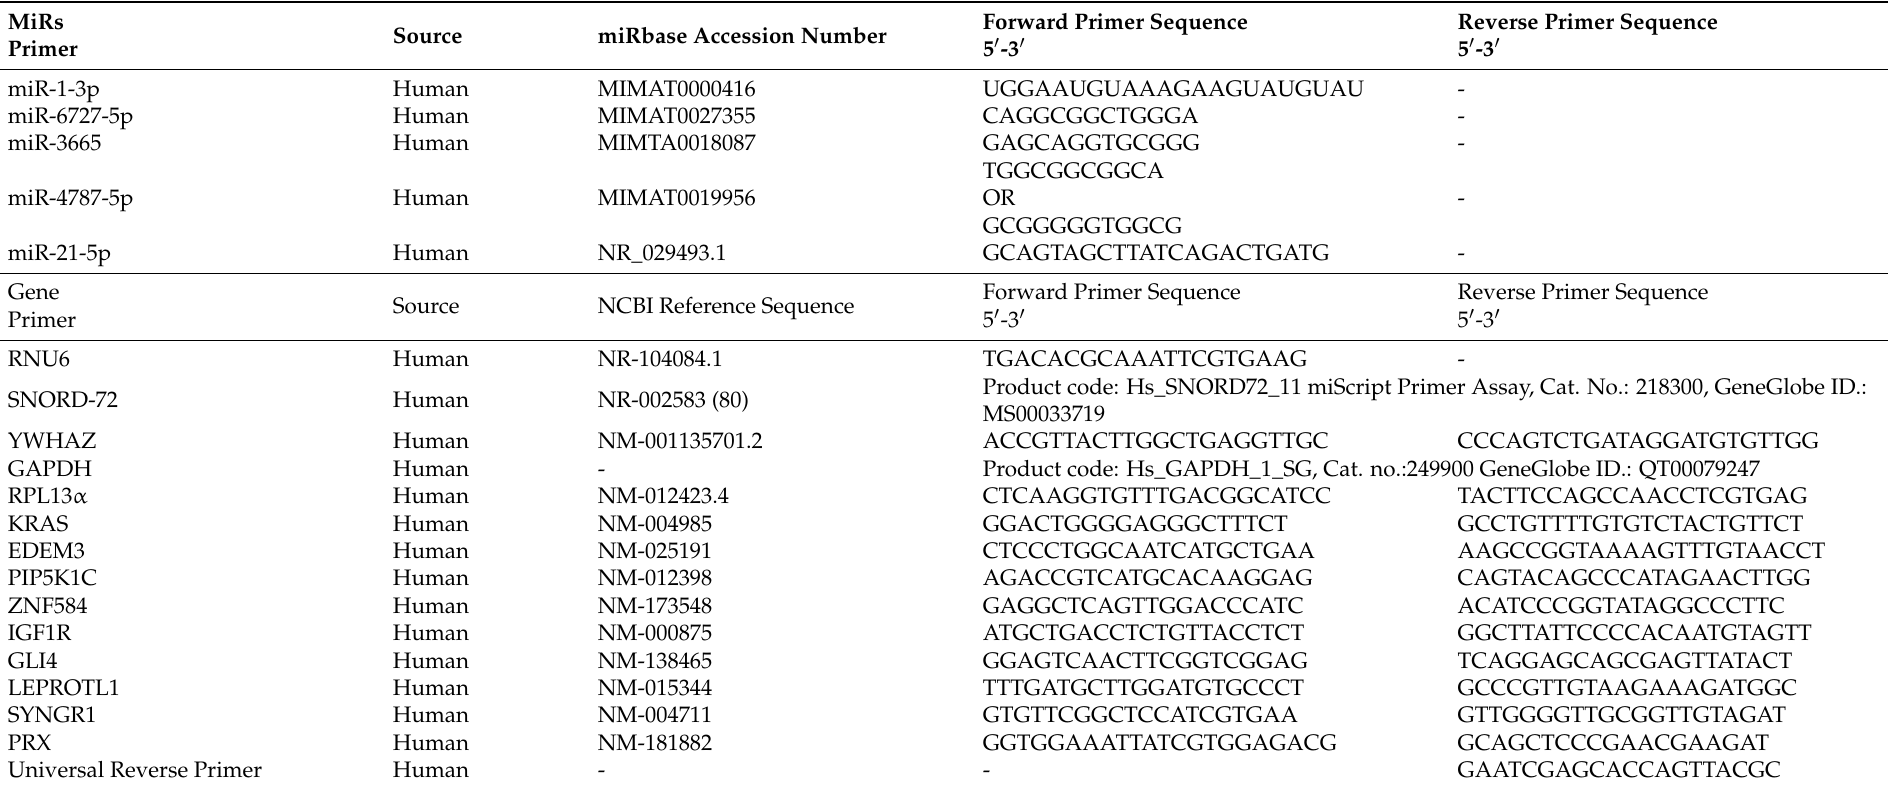
Table 1. Primer sequences employed to measure miRNA sequences and gene